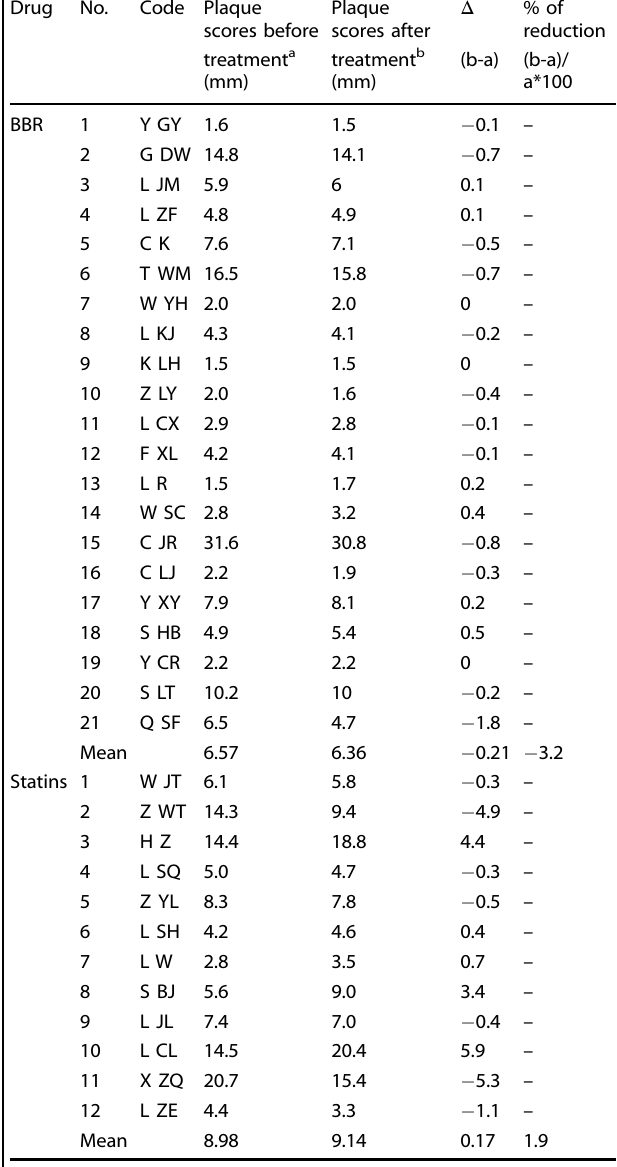
Table 1. Plaque scores of the atherosclerosis after drug treatment* Drug No. Code Plaque Plaque scores before scores